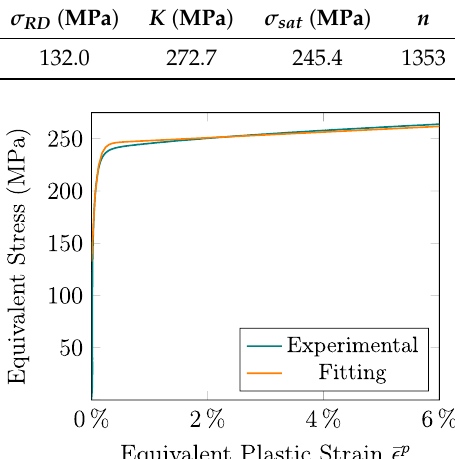
Figure 7. Fitting of the hardening parameters from the average experimental equivalent stress–equivalent plastic strain curve for the RD tensile